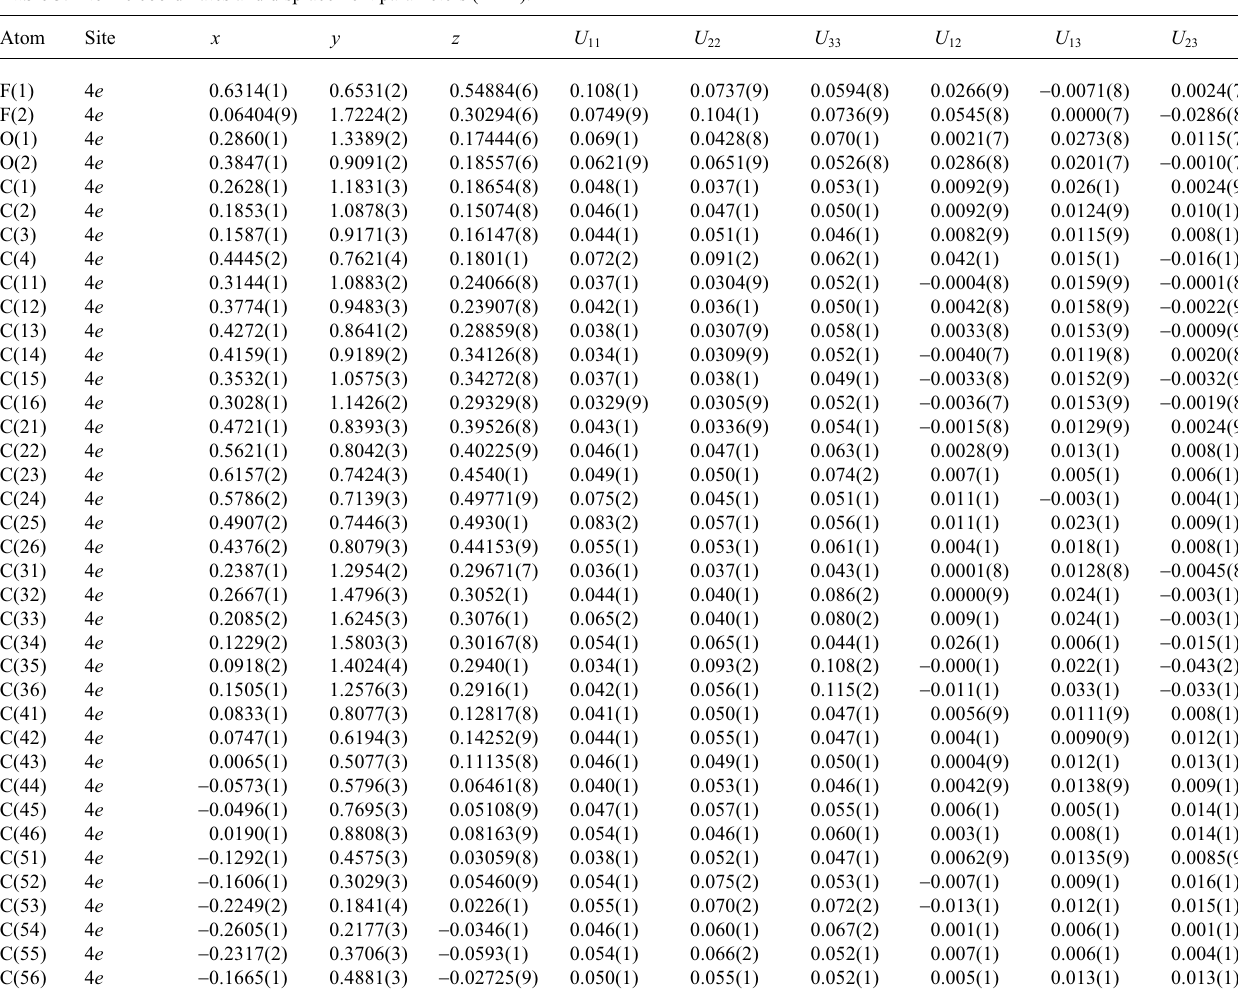
Table 3. Atomic coordinates and displacement parameters (in Å 2 )